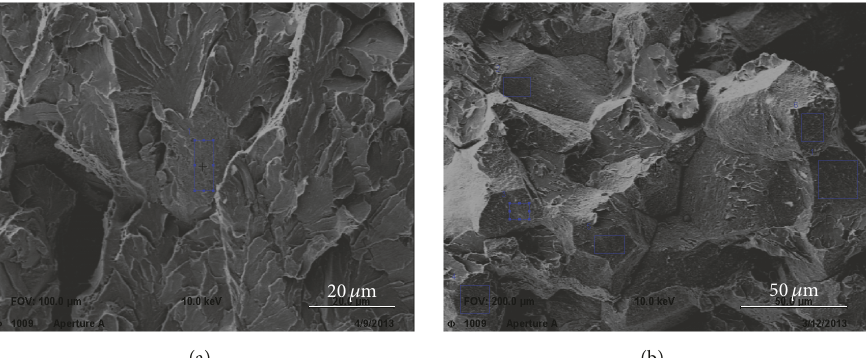
Figure 6: Images of grain boundary fracture surface for as-received (a) and aged (b) specimen obtained in PHI 700 Nanoprobe. Blue rectangles indicate areas of analysis for AES study.